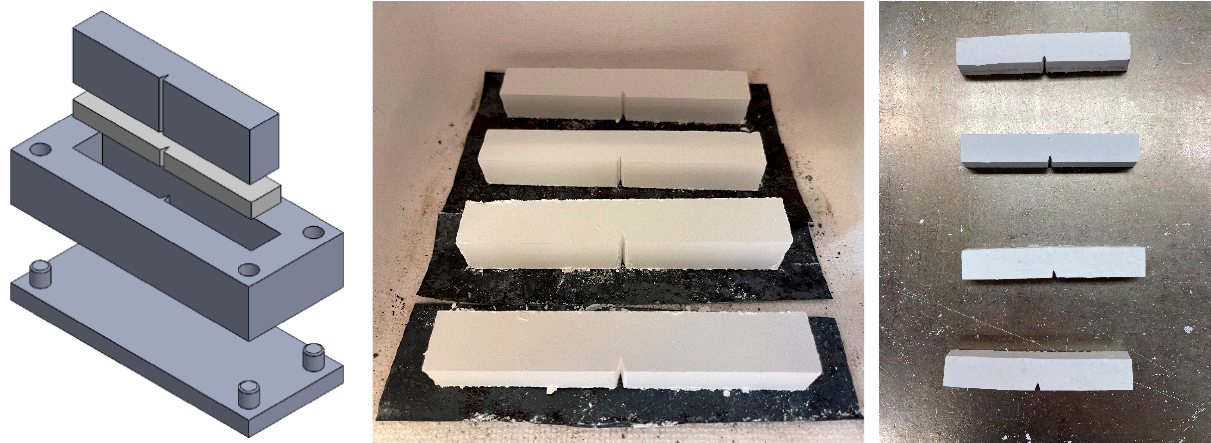
Figure 3. Powdered ash compressed into mold ( left ), compressed specimens placed in the furnace ( middle ), sintered deposit specimens removed from the furnace ( right ). ( middle ), sintered deposit specimens removed from the furnace ( right